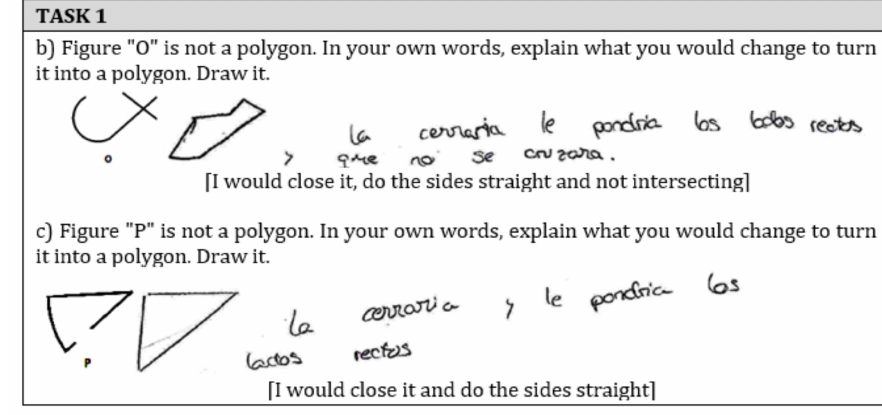
Figure 11. The answer given by student G2S7 when performing the task of transforming non- polygons into